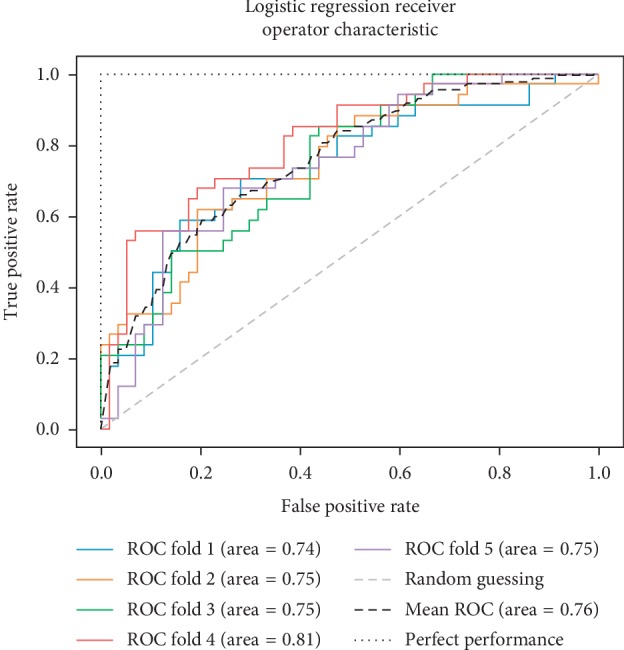
ROC curve for LR.